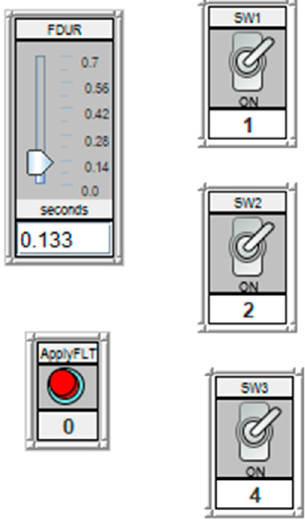
Figure 23. Applying fault to the system in RTDS environment.